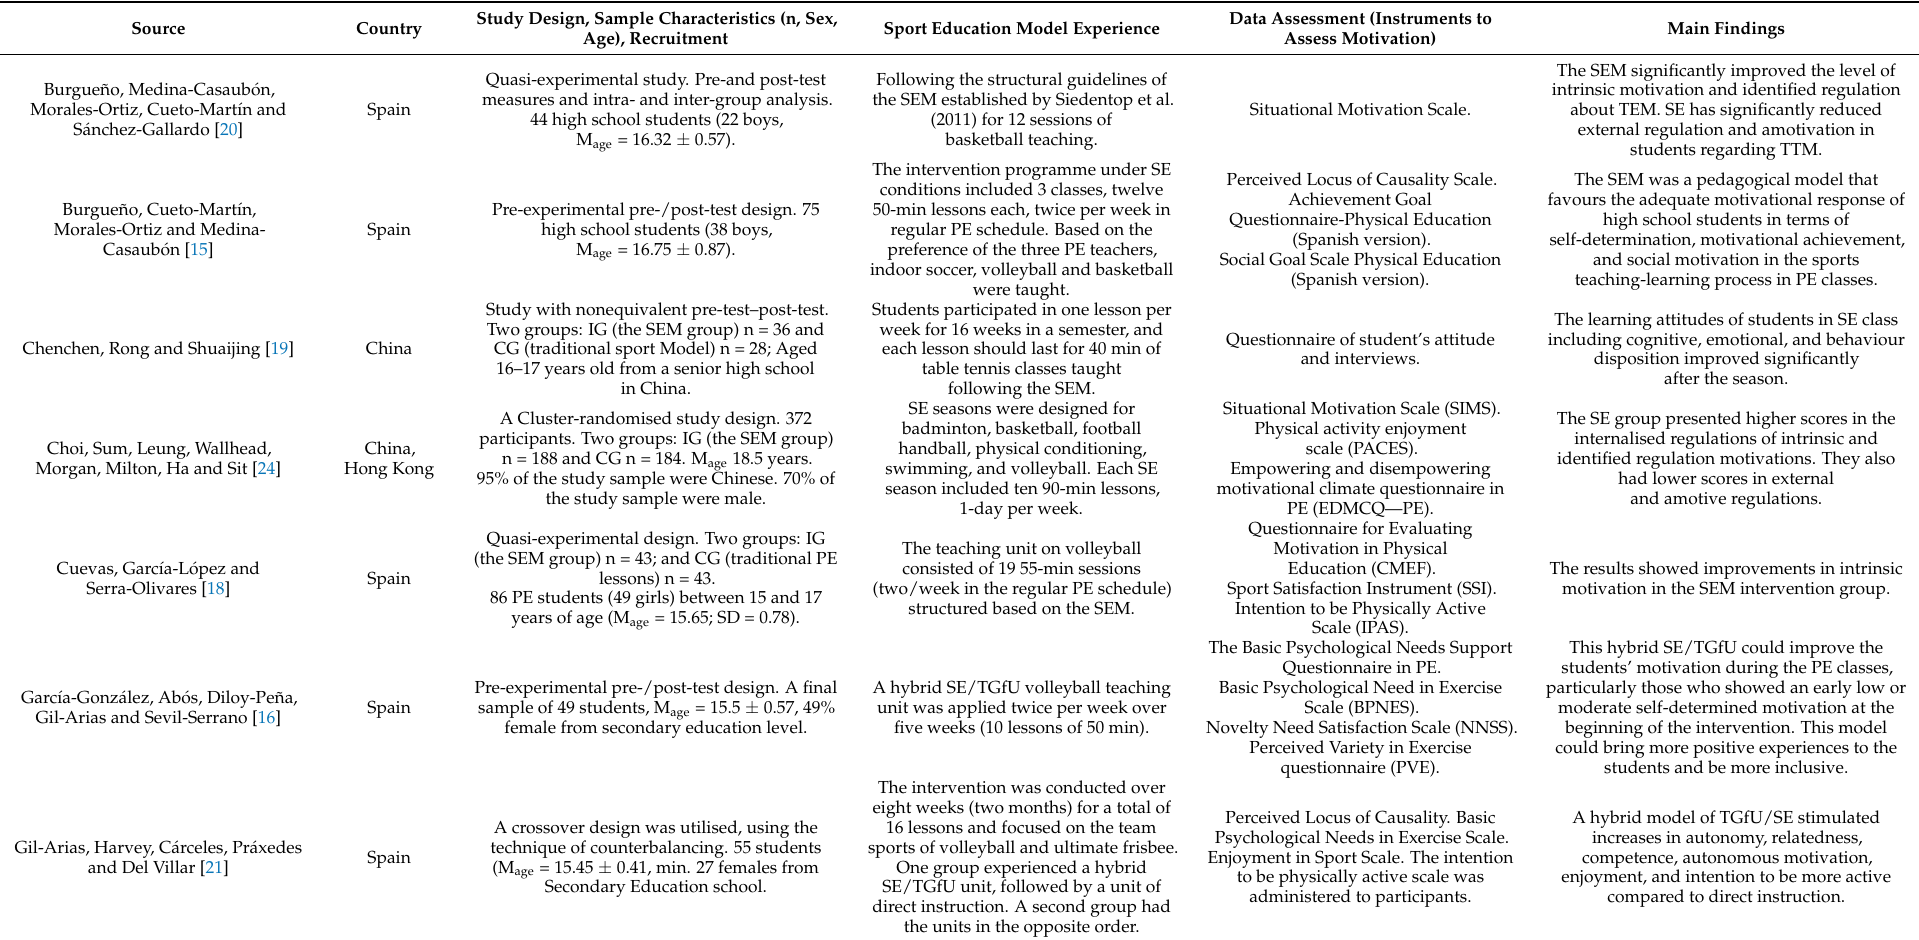
Table 1. Study characteristics and main